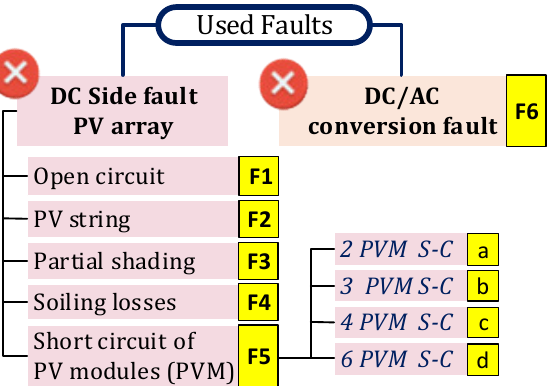
Figure 22. Used datasets faults for PLR method evaluation.